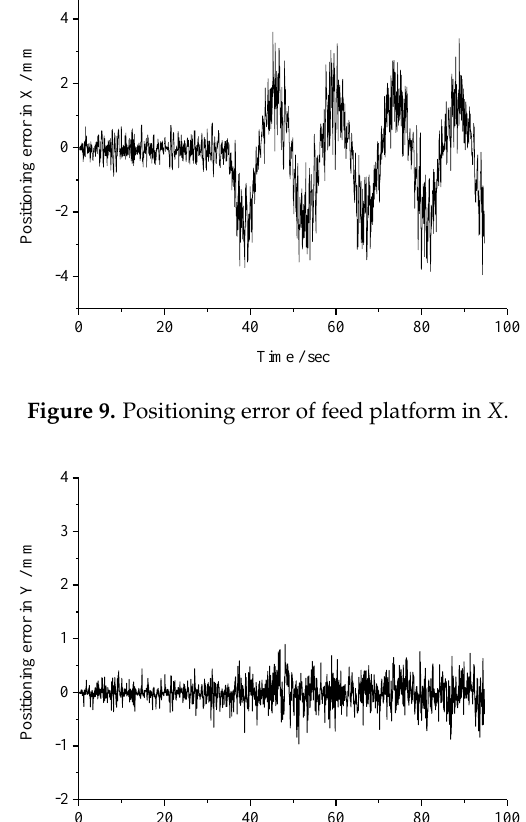
Figure 8 . X Displacement of the feed cabin and platform.